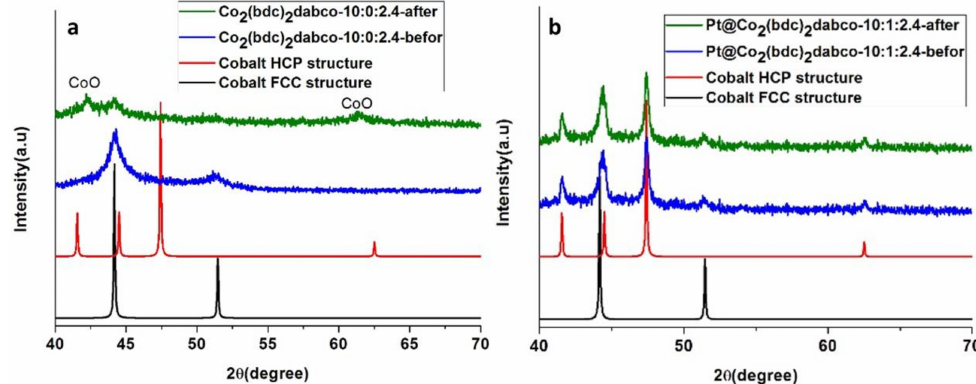
Figure 12. PXRD analysis of ( a ) Co/C and ( b ) Pt@Co/C, before and after Fischer-Tropsch